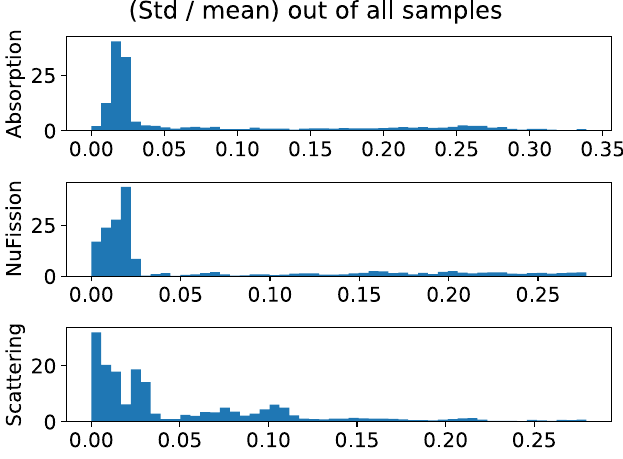
Fig. 4. Ratio of standard deviation (Std) over mean values of the pin-wise cross sections of all nuclides in the UGd